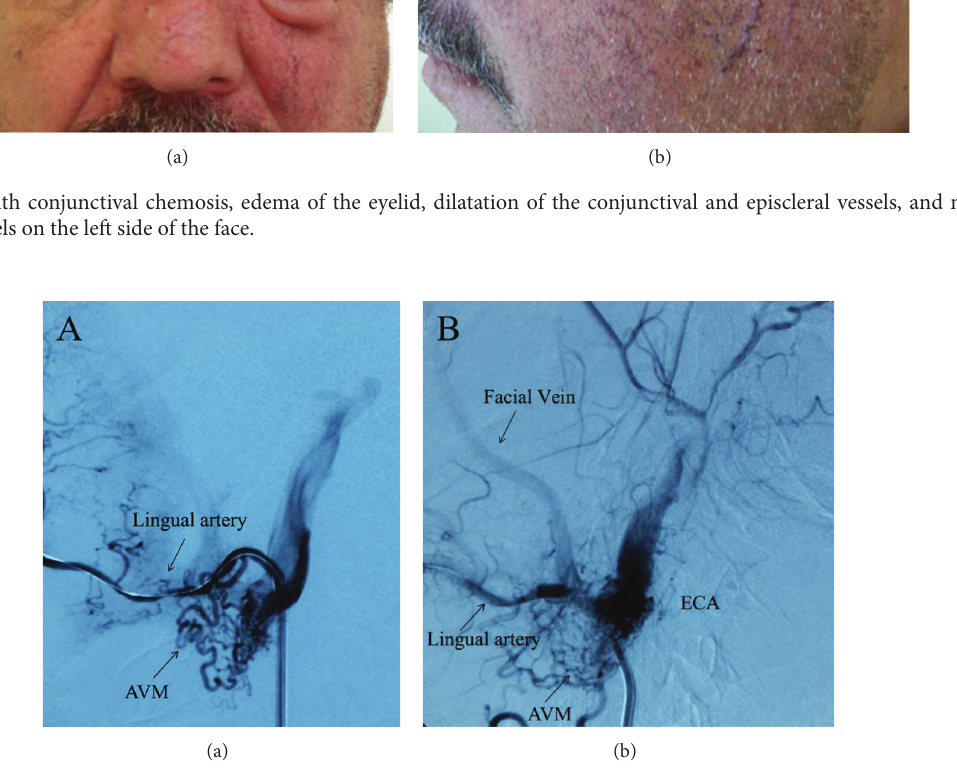
Figure 2: (a) Left external carotid artery and selective lingual artery catheterisation; digital subtraction angiography showed multiple fistulas originating from the lingual artery and draining into the facial vein. (b) Facial vein showed a filling towards the cranium. ECA: external carotid artery; AVM: arteriovenous